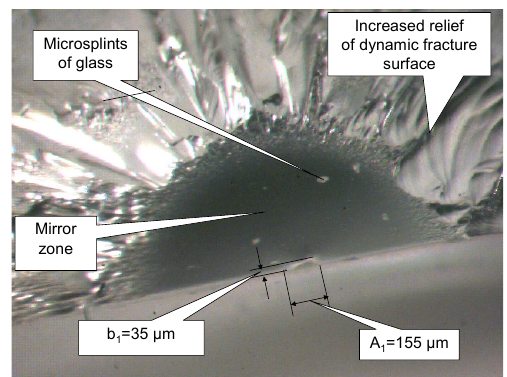
Figure 3: The analysis of limiting micro-crack parameters using the micrograph of fracture surface of tempered glass